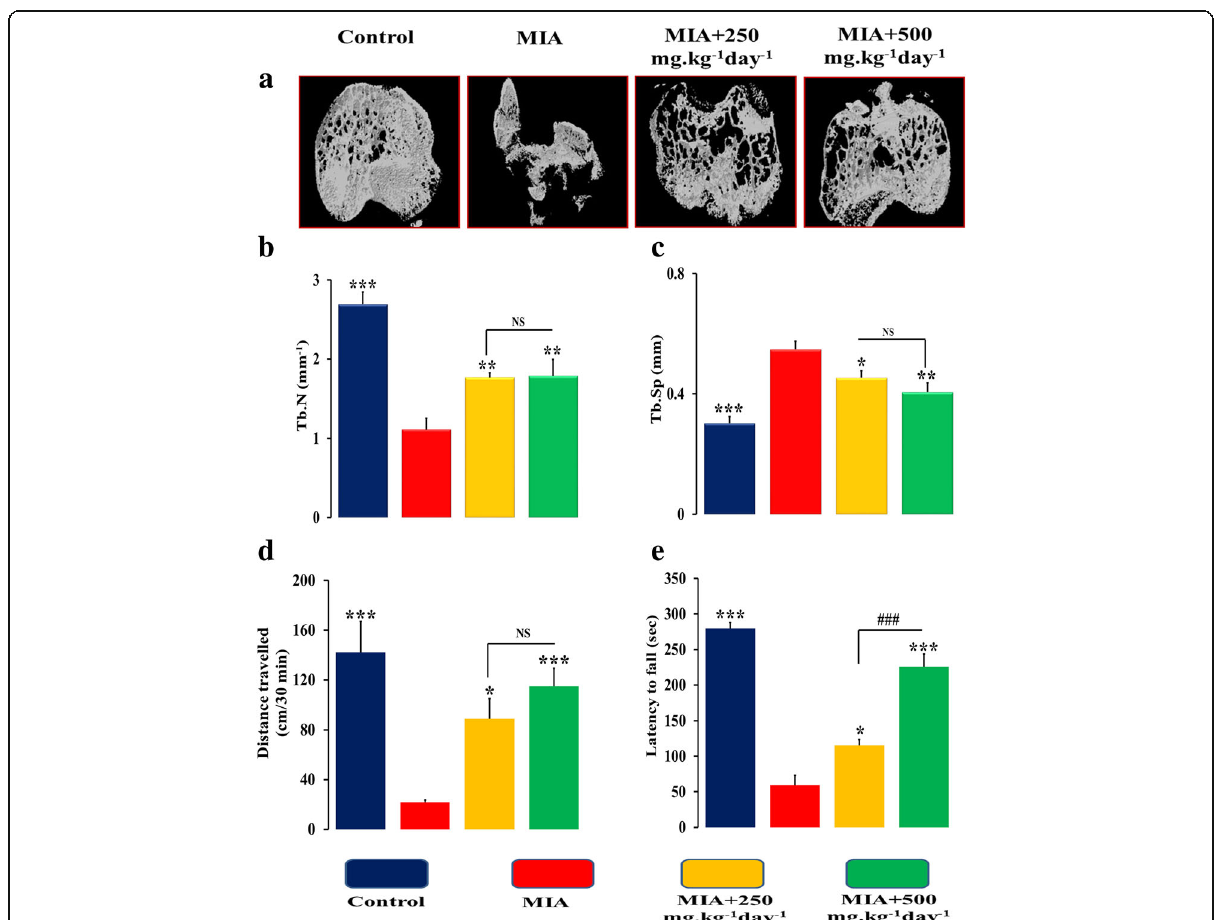
Fig. 5 SOE improves micro-architectural and behavioural parameters. a Representative 3D μ CT images of tibia plateau region of different groups. b Trabecular number (Tb.N, 1/mm); ( c ) Trabecular Separation; (Tb.Sp, mm) ( d ) Open-field activity and ( e ) Rota rod test to examine the locomotor function and motor coordination. All values are expressed as Mean ± S.E.M. ( n = 6/group); * P < 0.05, ** P < 0.01, *** P < 0.001 compared to the MIA group, ### P < 0.001 compared to the 250 mg.kg − 1 day − 1 dose, NS= non